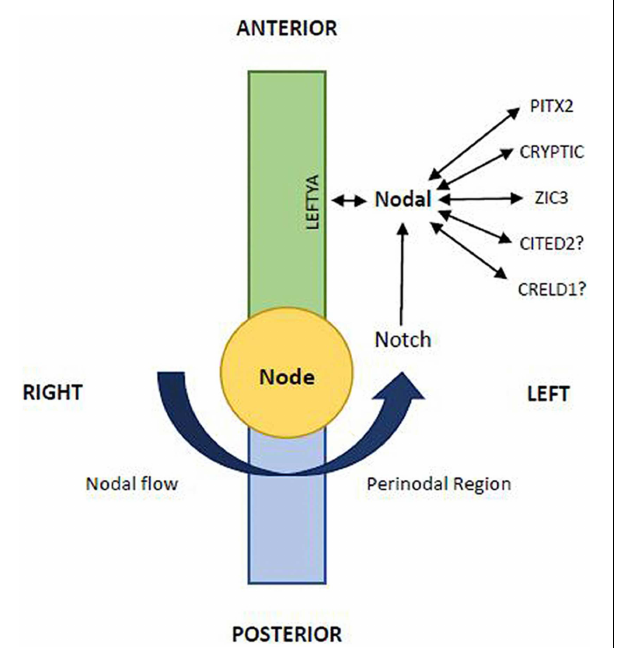
FIGURE 1 |The L–R pattering is caused at the node by an early breaking of bilateral symmetry .The nodal gene is essential in this function and the midline acts as a physical and molecular barrier to determine correct side-specific gene expression.The leftward Nodal flow (arrow) transport to the left wall of the node the nodal vesicular parcels. At this level Nodal interplays with other signalings including Notch, LeftyA, Cryptic, Pitx2,